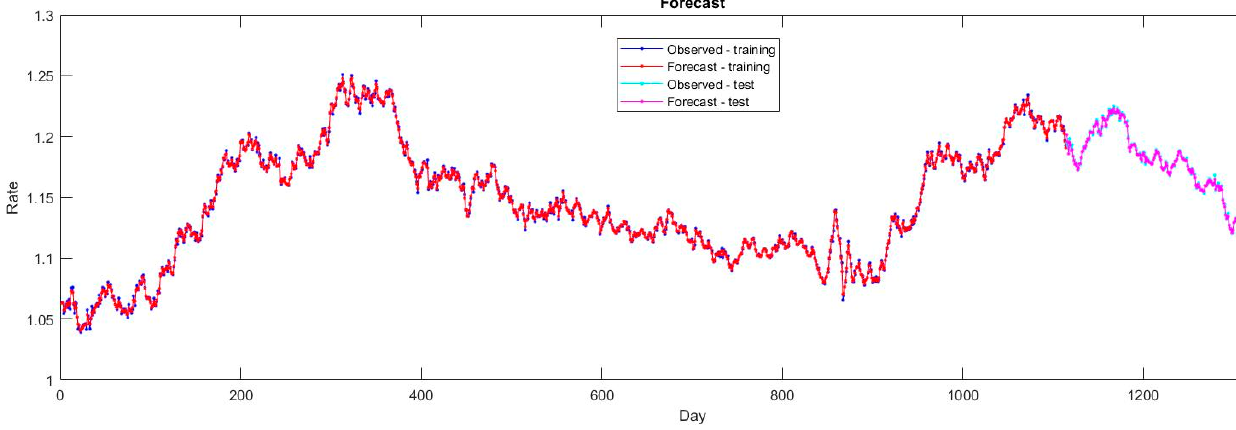
Figure 33. EUR–USD: ES-LSTM training.